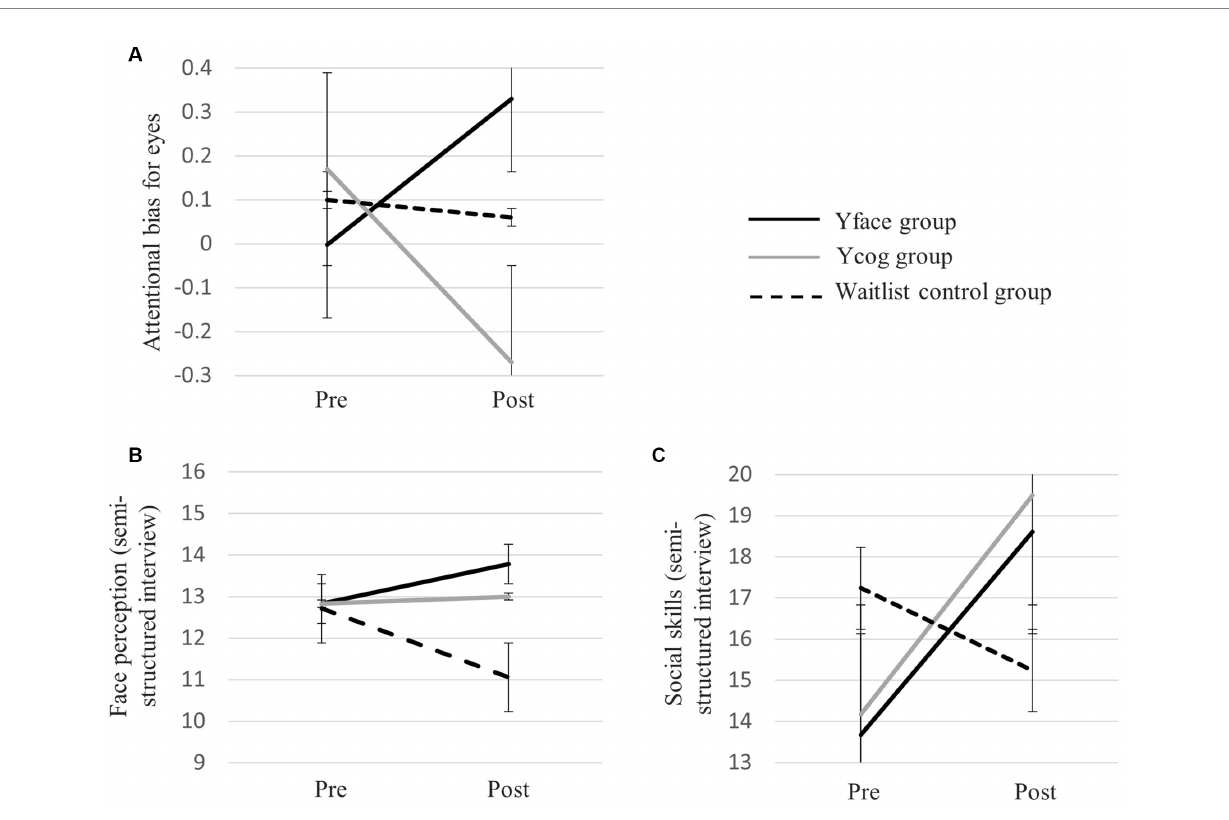
FIGURE 3 Graphs of the interaction effect of intervention group and time on (A) attentional bias for eyes from dot-probe task, (B) face perception from semi- structured interview, and (C) social skills from semi-structured